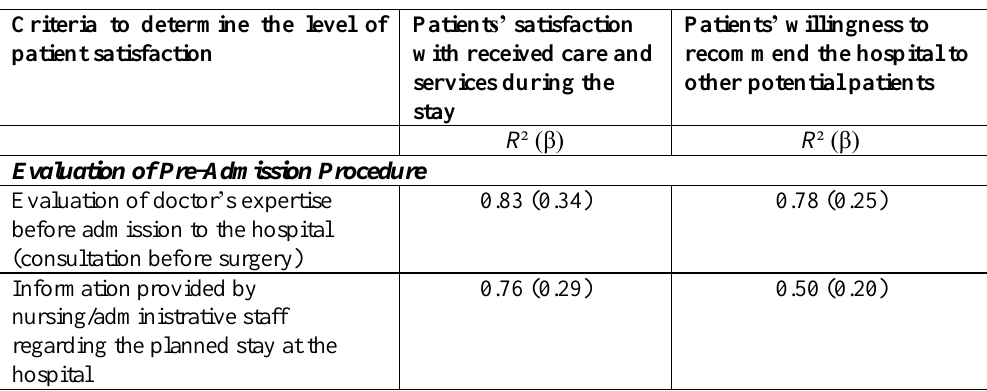
Table 2. Criteria which Received the Highest Score of Patients’ Satisfaction and Willingness to Recommend the